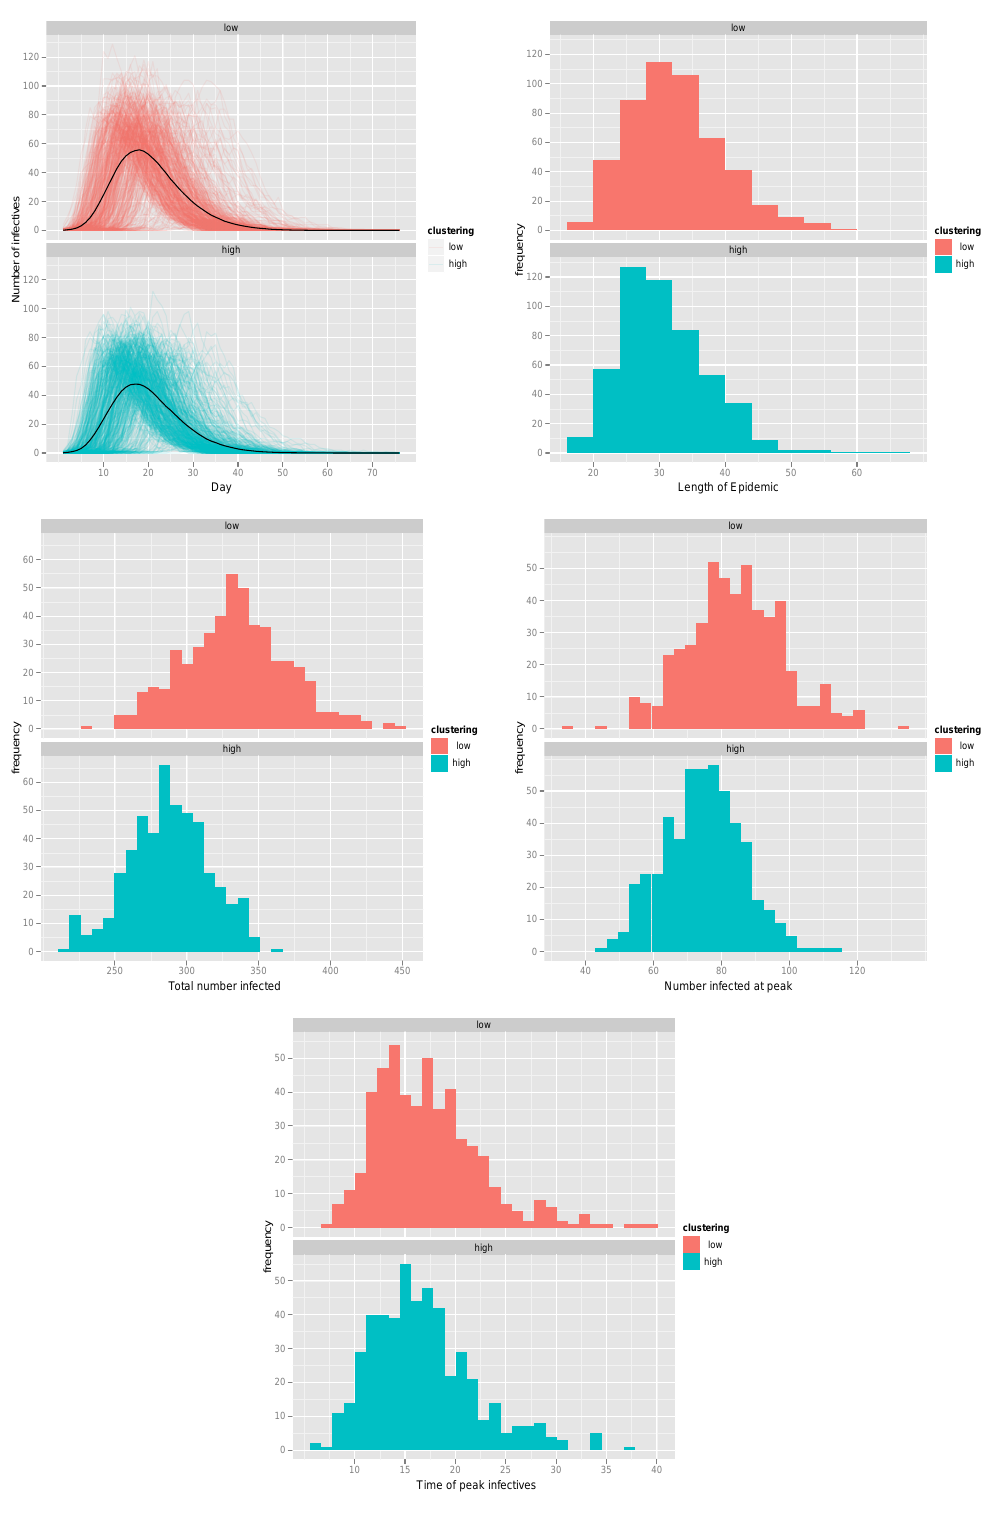
Figure 6. Empirical distributions of summary statistics of epidemics on power-law networks. (top left) Number of infected individuals through time with daily mean shown in black; (top right) Length of epidemic; (centre left) Maximum number infected at peak of outbreak; and, (bottom) Time of outbreak peak